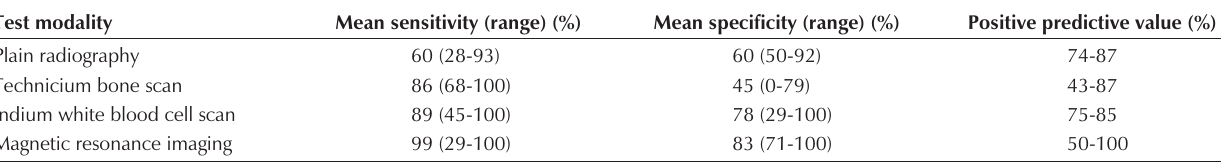
Imaging techniques for identifying osteomyelitis in the feet of people with diabetes Test modality Mean sensitivity (range) (%) Mean specificity (range) (%) Positive predictive value (%) Plain radiography